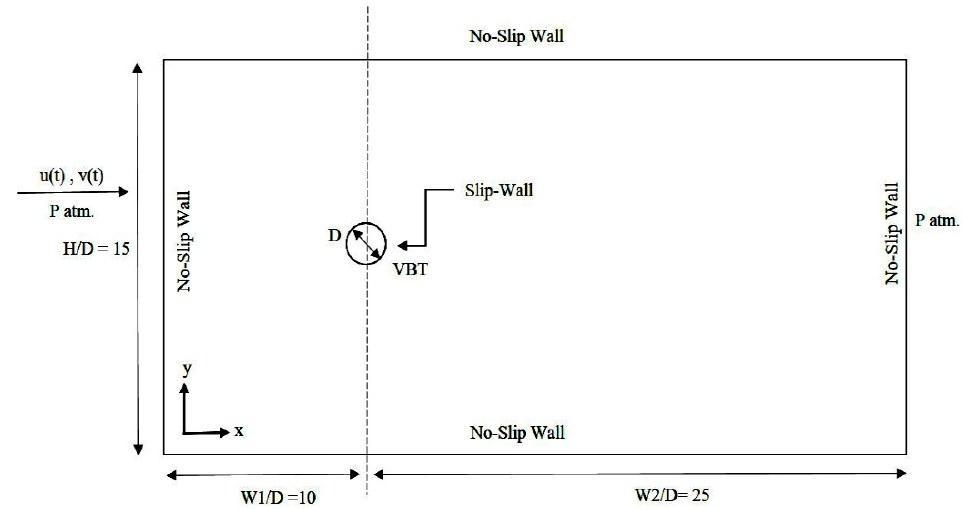
Figure 2. The schematic view of dimensionless parameters and boundary conditions.